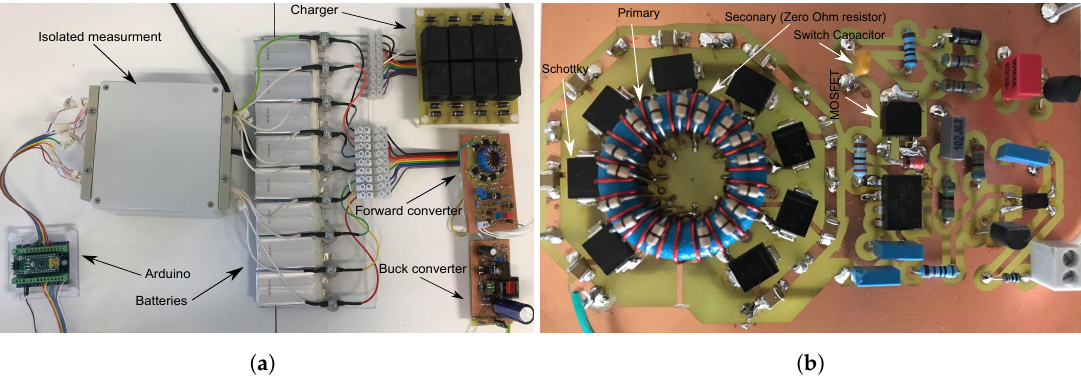
Figure 16. ( a ) Practical implementation of the forward-buck converter; ( b ) PCB prototype of the forward